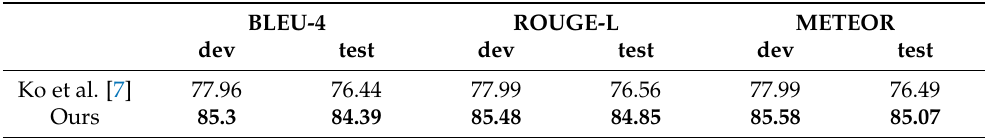
Table 8. Comparison with other models in KETI dataset.